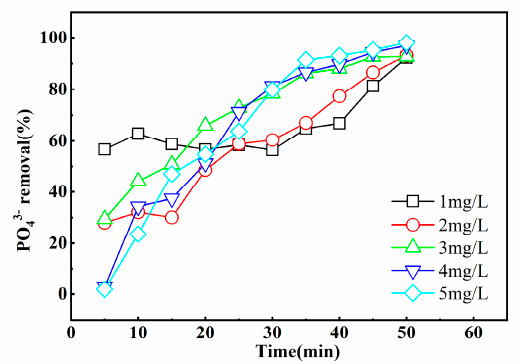
Figure 6. The relationship between the initial phosphate concentration and phosphate removal in the aluminum − air fuel cell.